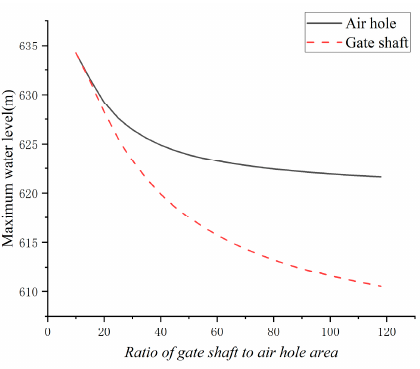
Figure 7. Maximum water level by the different area ratios of gate shaft and air hole .